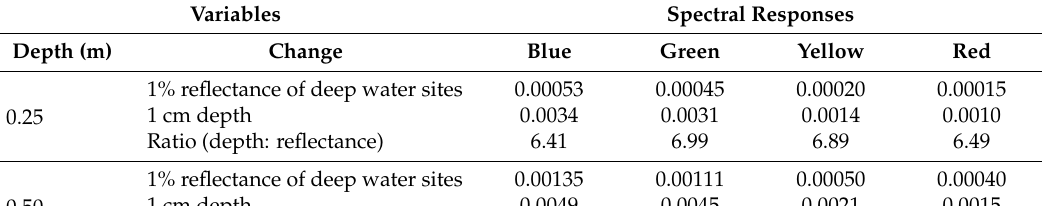
Table 5. Spectral sensitivity at depth, reflectance change of deep water and depth change.